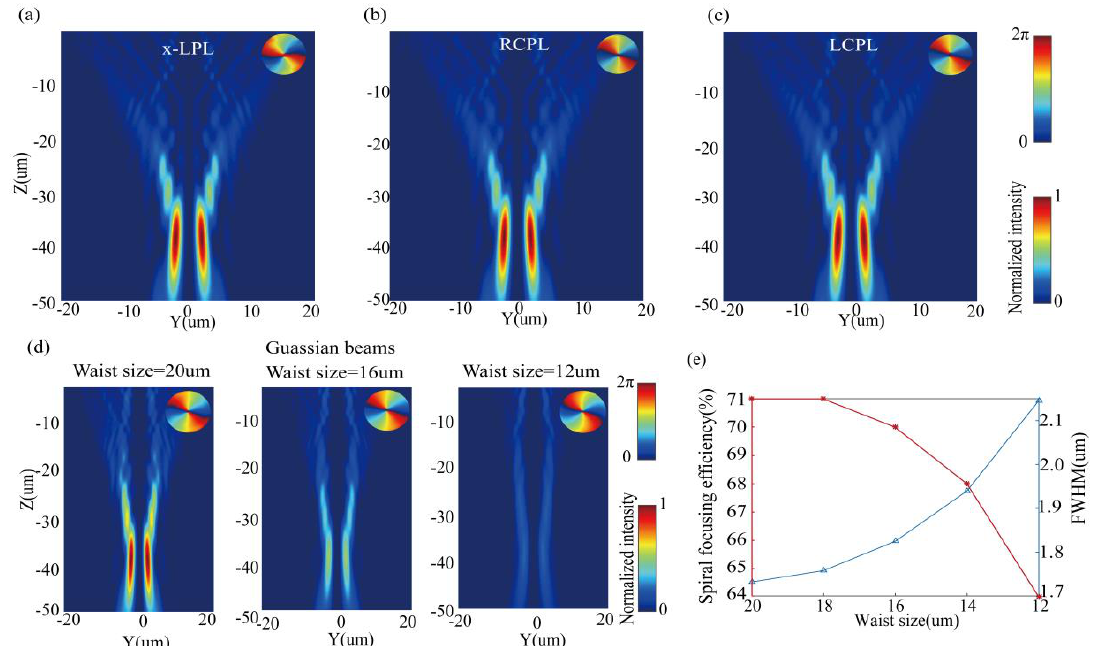
Figure 7. Simulated transmitted intensity profiles on the y–z cross section of the MSF generator for the normal incidences of ( a ) x-LPL, ( b ) right-handed circular polarization light, ( c ) left-handed circular polarization light. ( d ) Simulated transmitted intensity profiles on the y–z cross section of the MSF generator for the normal incidences of Gaussian beams with different waist sizes. ( e ) Simulated values of FWHM and spiral focusing efficiency for the normal incidences of Gaussian beams with different waist sizes.